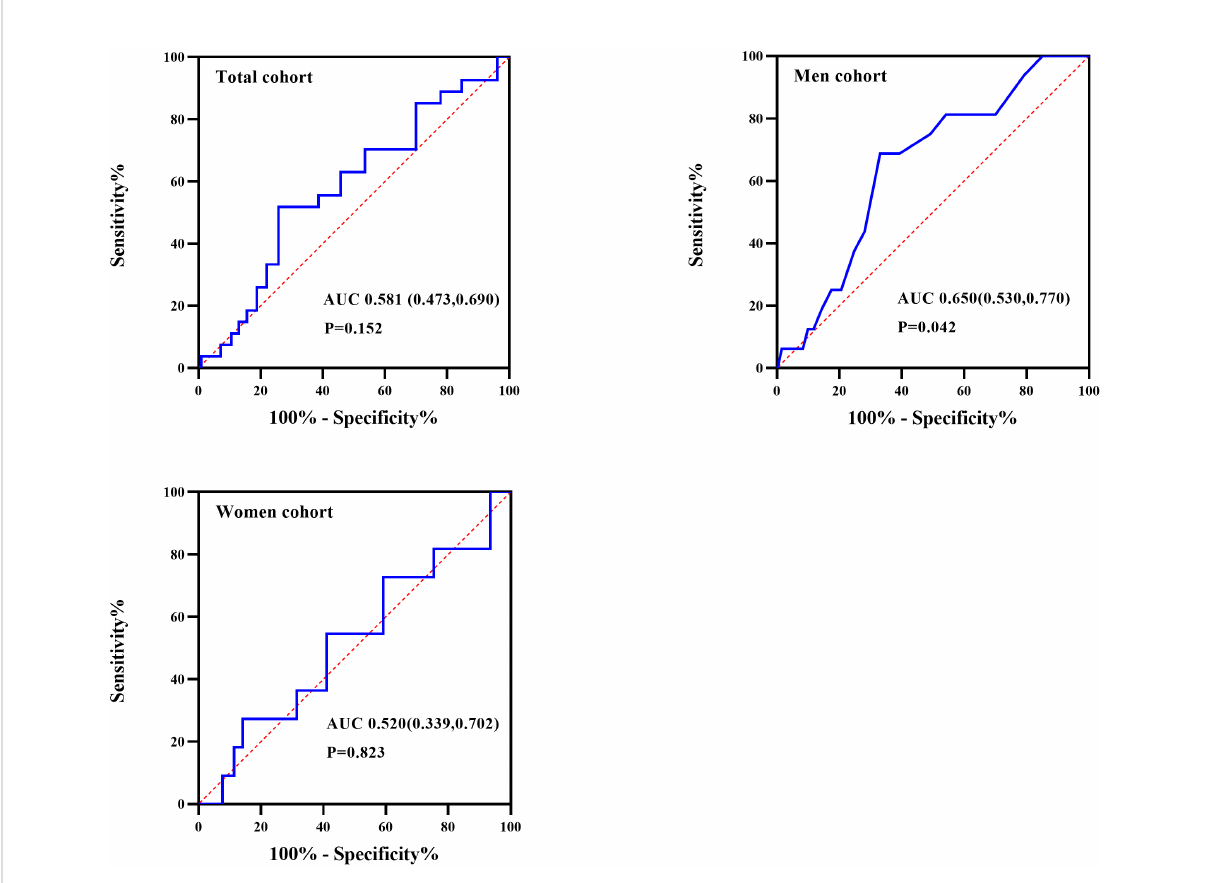
FIGURE 2 Receiver operating characteristic (ROC) curve analysis of Epworth sleepiness scale (ESS) to recognize hypothyroidism in total, men, and women participants with